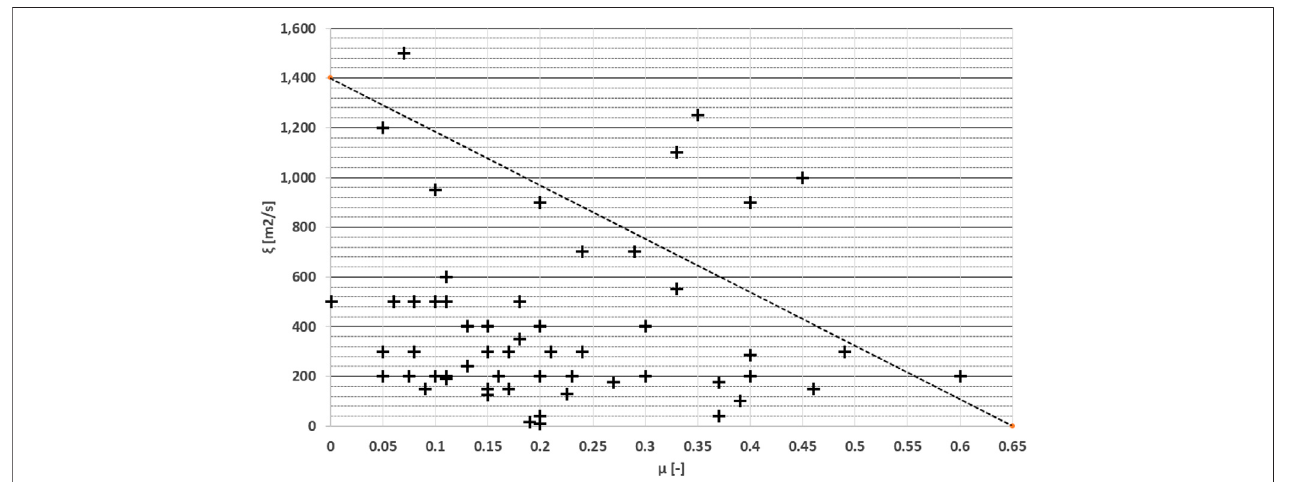
FIGURE1| RangeoftheVoellmy- fl uidfrictionparameters( μ and ξ )usedintheanalyzedstudiesshownin Table1 ,excludingonestudywithverylarge ξ parameter, (i.e. Chung et al., 2018).